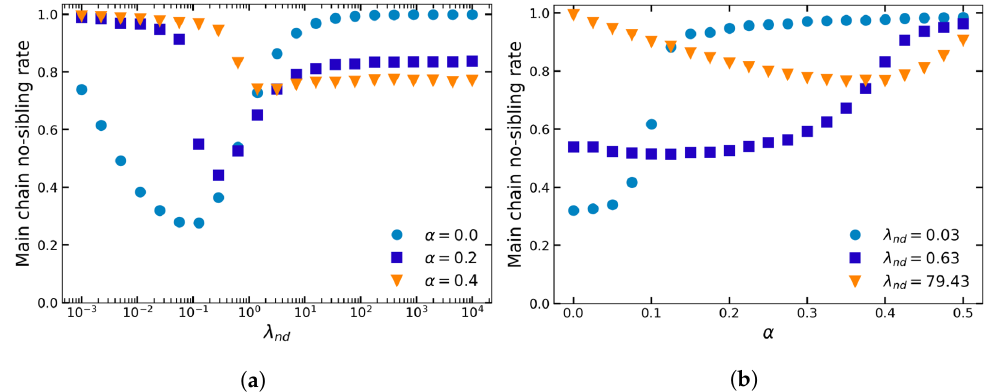
Figure 7. Share of main chain blocks that have no siblings as a function of: ( a ) latency ( λ nd ) and ( b ) selfish hashing power ( α